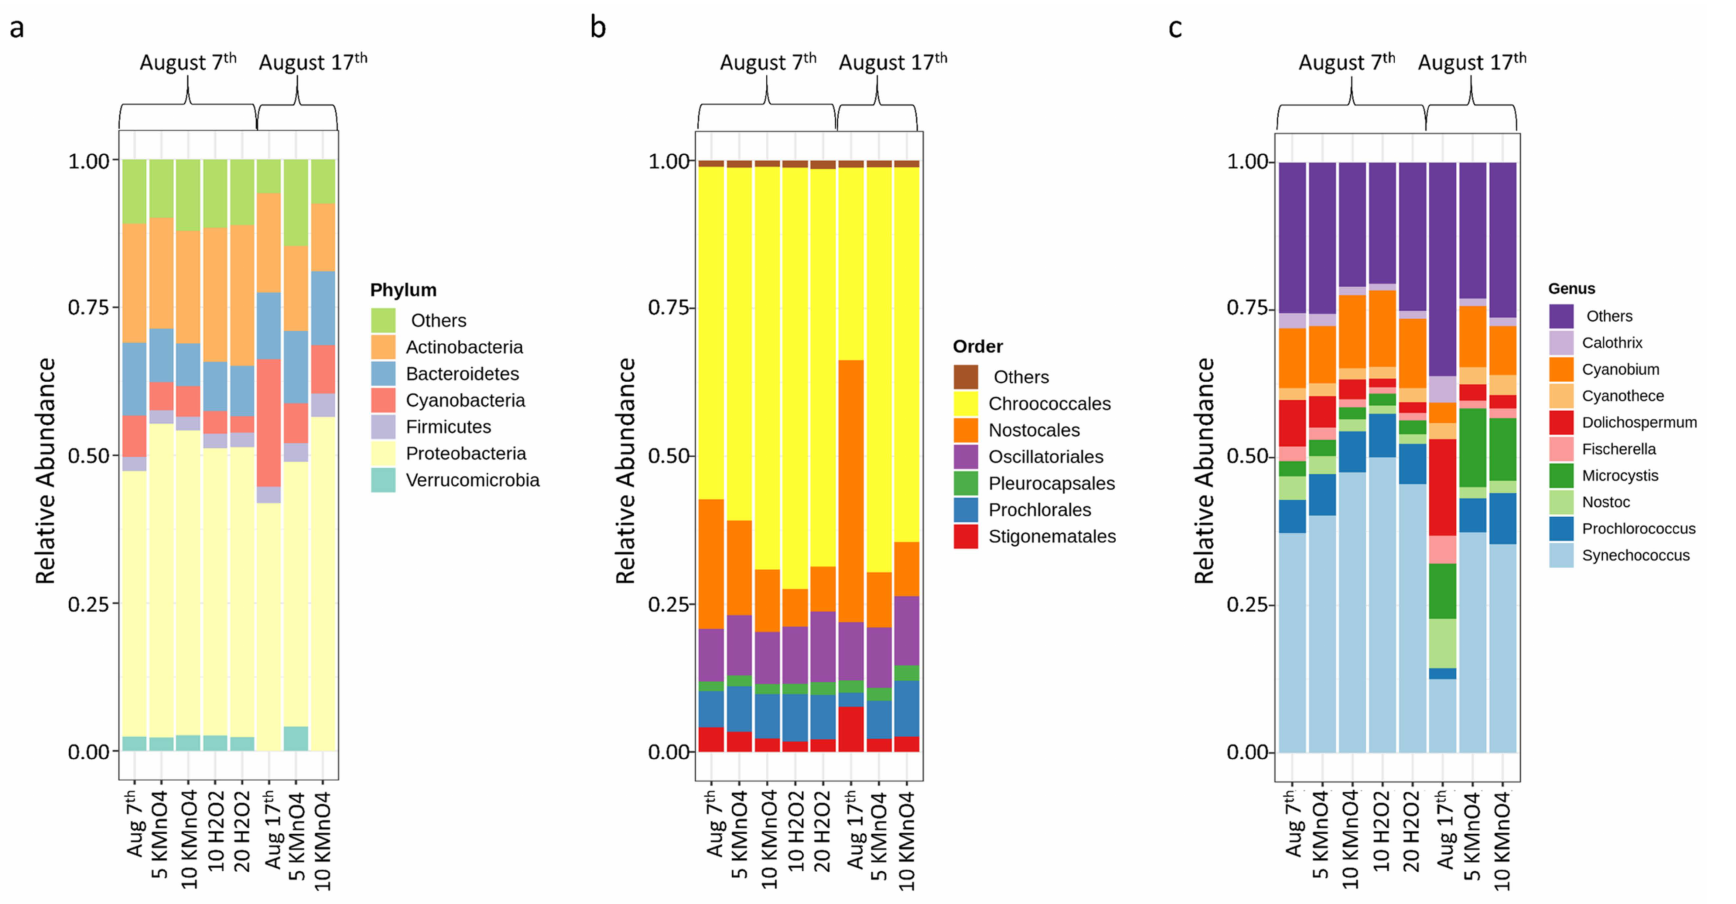
Figure 4. Impact of laboratory oxidation on ( a ) Microbial relative abundance at the phylum level, ( b ) Cyanobacterial relative abundance at the orders and ( c ) Cyanobacterial relative abundance at the genus level on 7 and 17